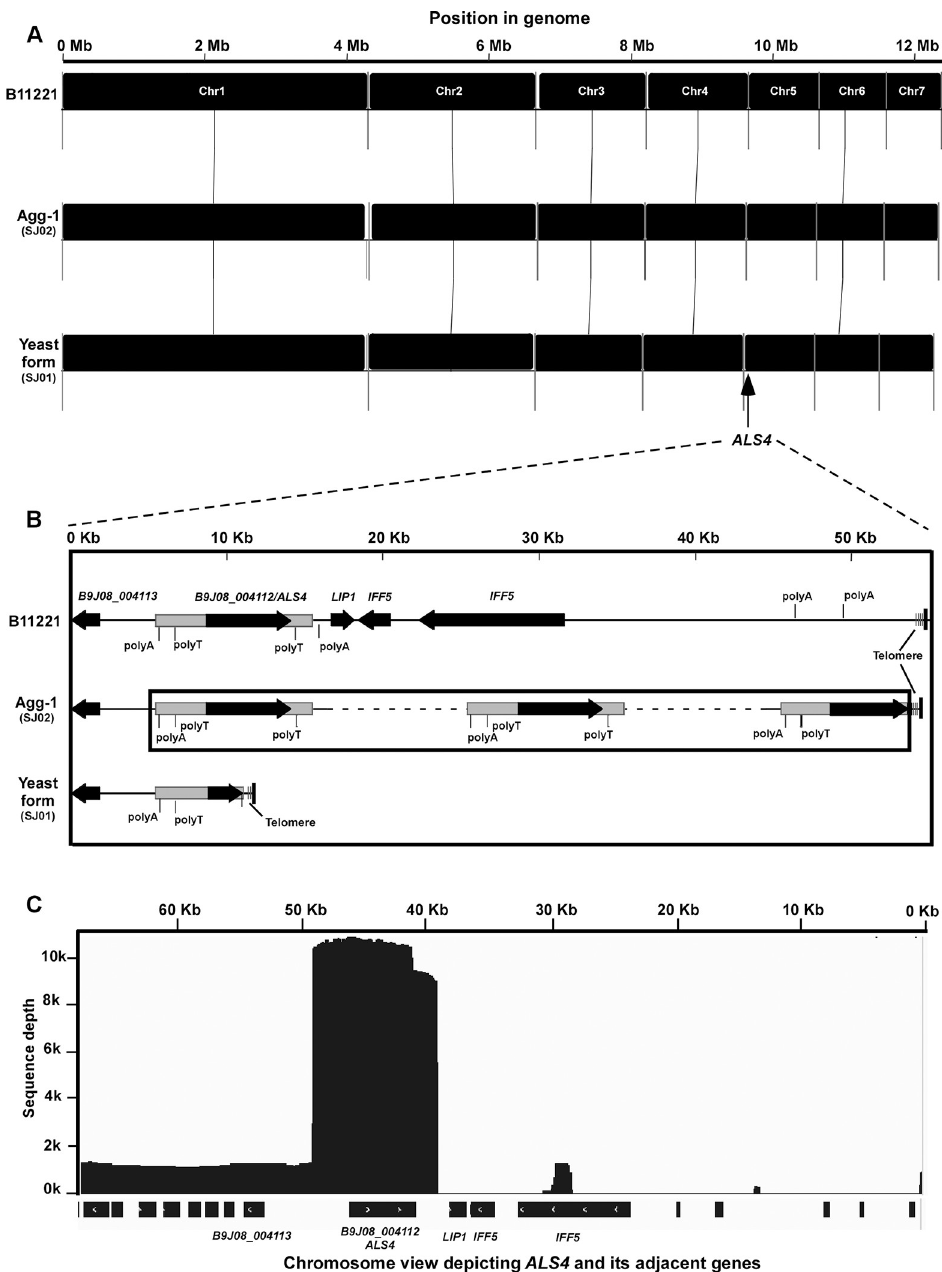
Fig 7. Genomic analysis of the nonaggregative/yeast-form (SJ01) and aggregative-form (SJ02) strains of C . auris . Long-read sequencing and data analyses were performed. (A) Genome synteny among strains SJ01, SJ02, and reference strain B11221. Black blocks indicate shared syntenic regions of the genomes. (B) Synteny schematic depicting the orientation and conservation of ALS4 and its adjacent genes. The copy number was estimated using Illumina sequencing data. Tandem repeats of ALS4 are indicated by dashed lines. (C) Sequence depth of ALS4 and its adjacent region (estimated based on PacBio Sequel II sequencing data). The sequence depth was calculated by IGV.